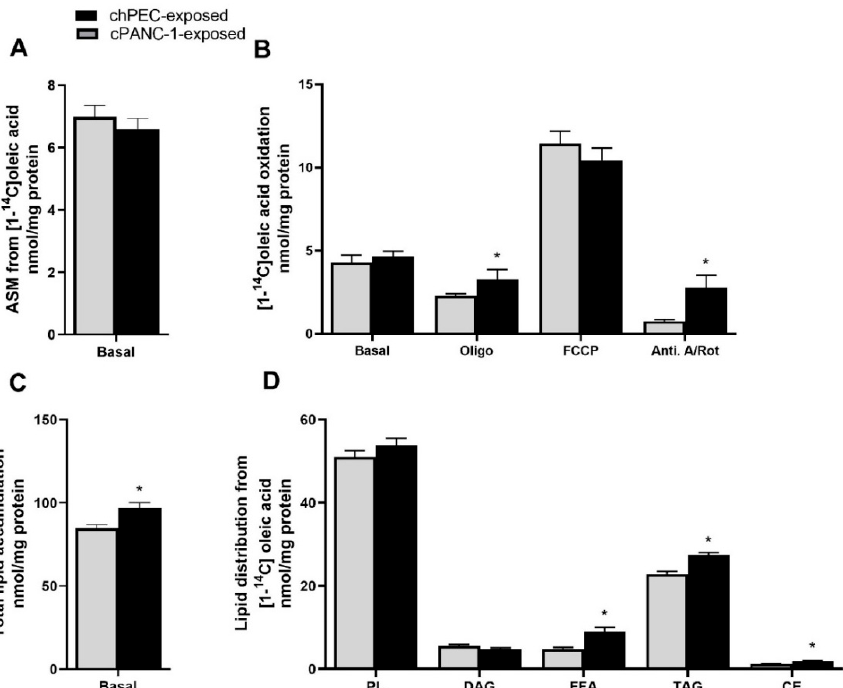
Figure 5. Fatty acid metabolism in PANC-1- and hPEC-conditioned myotubes. In the last 4 days of differentiation, myotubes were conditioned with the medium from hPECs (chPEC exposed) or PANC-1 cells (cPANC-1 exposed). Thereafter, the muscle cells were incubated with [1- 14 C]oleic acid (18.5 kBq, 100 µmol/L) in the presence or absence of 1 µmol/L of oligomycin (electron transport chain (ETC) complex V inhibitor), 1 µmol/L of FCCP (mitochondrial uncoupler), or 2.5 µmol/L of antimycin A (ETC complex III inhibitor) combined with 0.5 µmol/L of rotenone (ETC complex I inhibitor) for 4 h. ( A ) Incomplete oxidation measured as acid-soluble metabolites (ASM). ( B ) Complete oxidation measured as trapped CO 2 . ( C ) Total lipid accumulation and ( D ) lipid distribution. Values are presented as the mean ± SEM in absolute values as nmol/mg of protein. Data are from three individual experiments, each with two biological replicates ( n = 6). * Statistically significant in cPANC-1-exposed versus chPEC-exposed myotubes ( p ≤ 0.05, paired t -test). CE, cholesteryl ester; DAG, diacylglycerol; FFA, free fatty acids; PL, phospholipid; TAG,